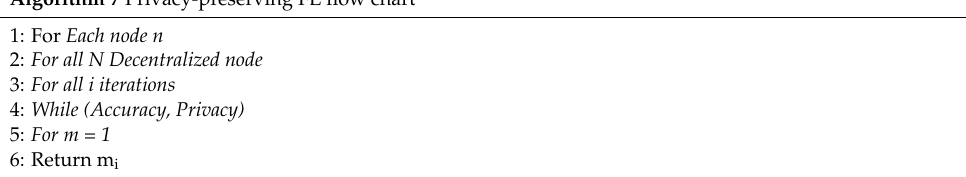
Algorithm 7 Privacy-preserving FL flow